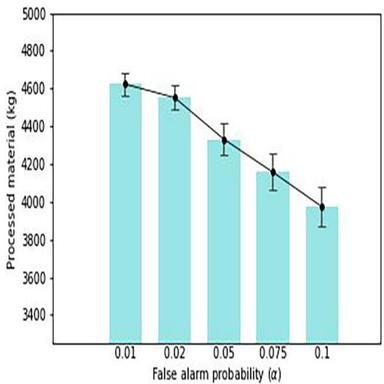
1. With the false alarm probability of 0.01, the average amount of 4622 ± 58.3 kg is processed. The following average amounts given the false alarm probabilities of 0.02, 0.05, 0.075, and 0.1 are 4552 ± 64.9 kg, 4332 ± 81.8 kg, 4156 ± 96.0 kg, and 3973 ± 102.0 kg.